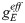
Direct validation of IM from realistic neuron simulations.Given the same pair of the synaptic inputs simultaneously as shown in Fig 4c to obtain reference effective E and I conductances gEeff and gIeff, an I-V relation at a particular moment can be obtained by holding the somatic voltage at different levels. a, the deviation of the slope of the I-V relation (red dash curve) from the total conductance (blue curve) calculated as gEeff+gIeff. b, good agreement between the intercept of the I-V relation (red dash curve) and the reversal current (blue curve) calculated as gEeffεE+gIeffεI.